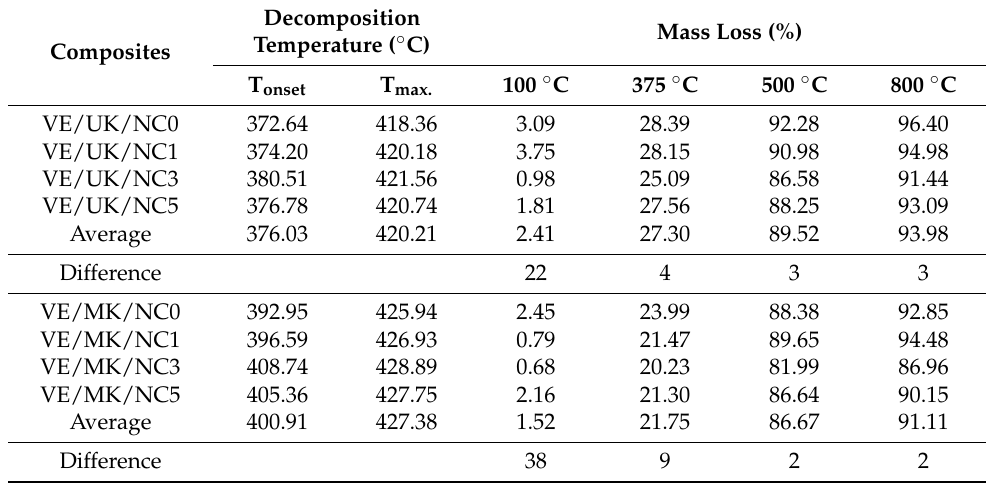
Figure 10. FT ‐ IR analysis of modified and unmodified kenaf fibre enhanced nanocomposites. Figure 10. FT-IR analysis of modified and unmodified kenaf fibre enhanced nanocomposites. Table 2. Decomposition temperatures and mass loss data of